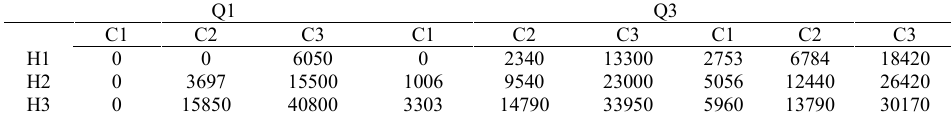
) in all the experiments f